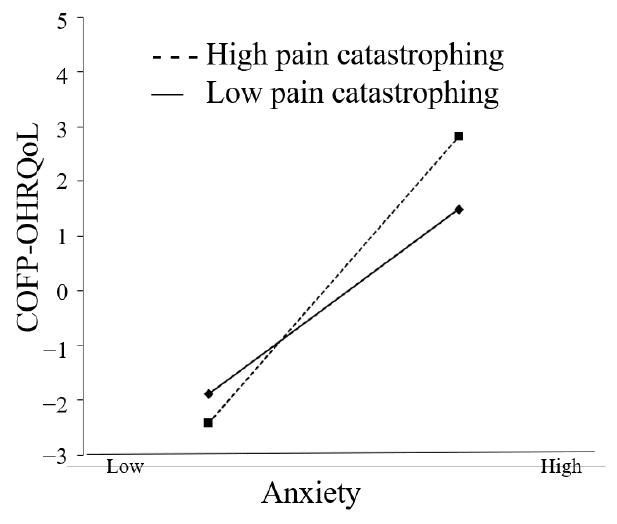
Figure 3. Moderating effect on the relationship between anxiety and COFP-OHRQoL.